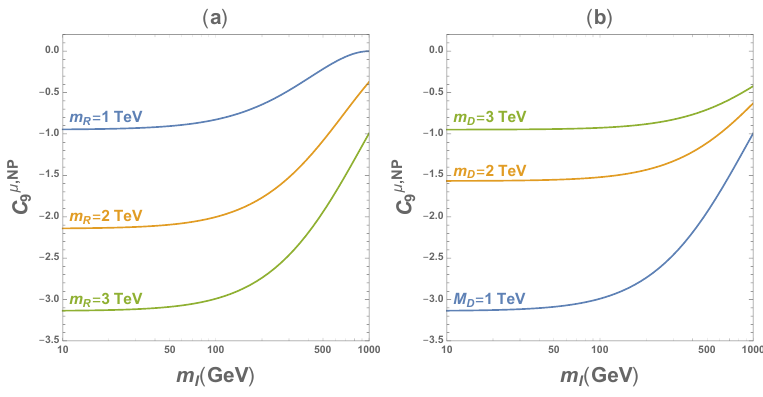
Figure 2 . Plots of C (cid:22); NP